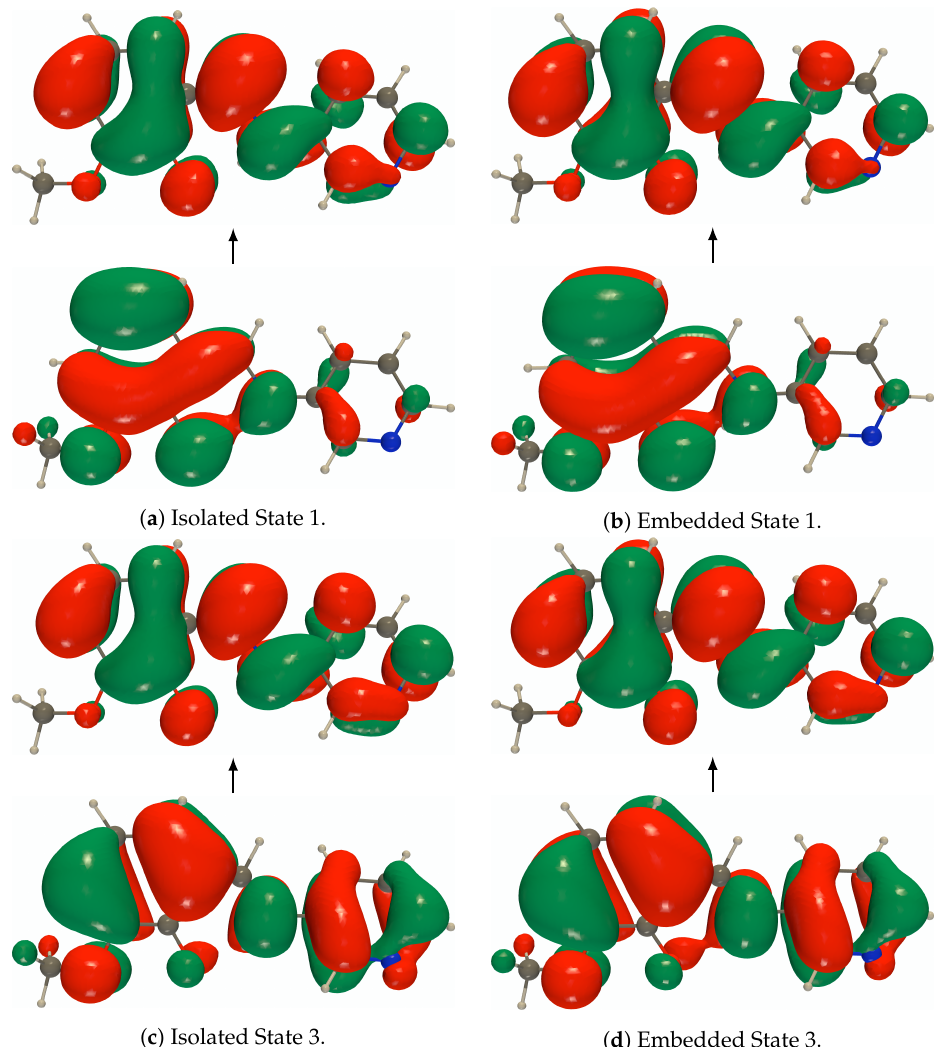
Figure A6. RI-CC2/def2-TZVPD NTOs (holes below the arrows and particles above them, the red (green) lobes are the positive (negative) ones) of the isolated and embedded PYV3 [PYV3] keto form (isovalue of